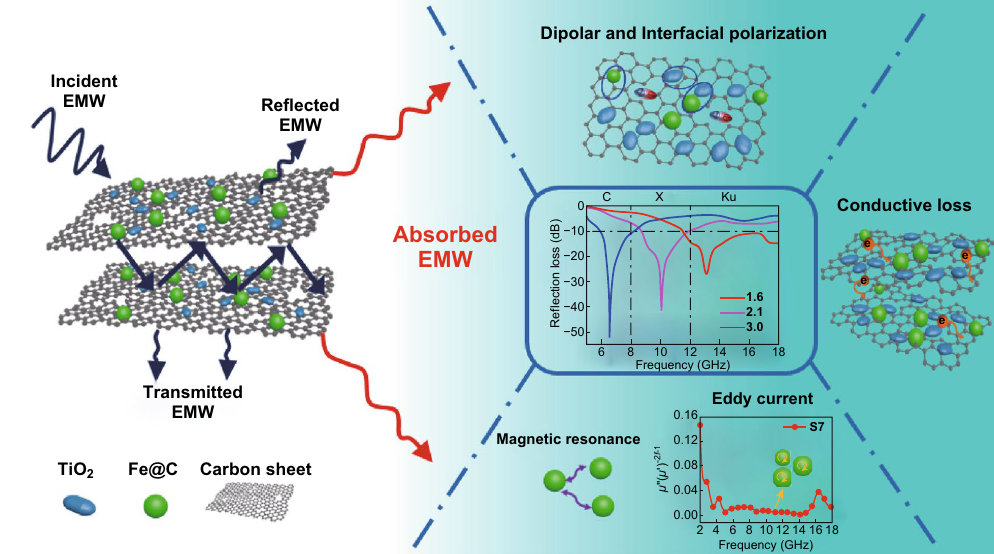
Fig. 9 Illustration of EMW absorption mechanisms for Fe&TiO 2 @C